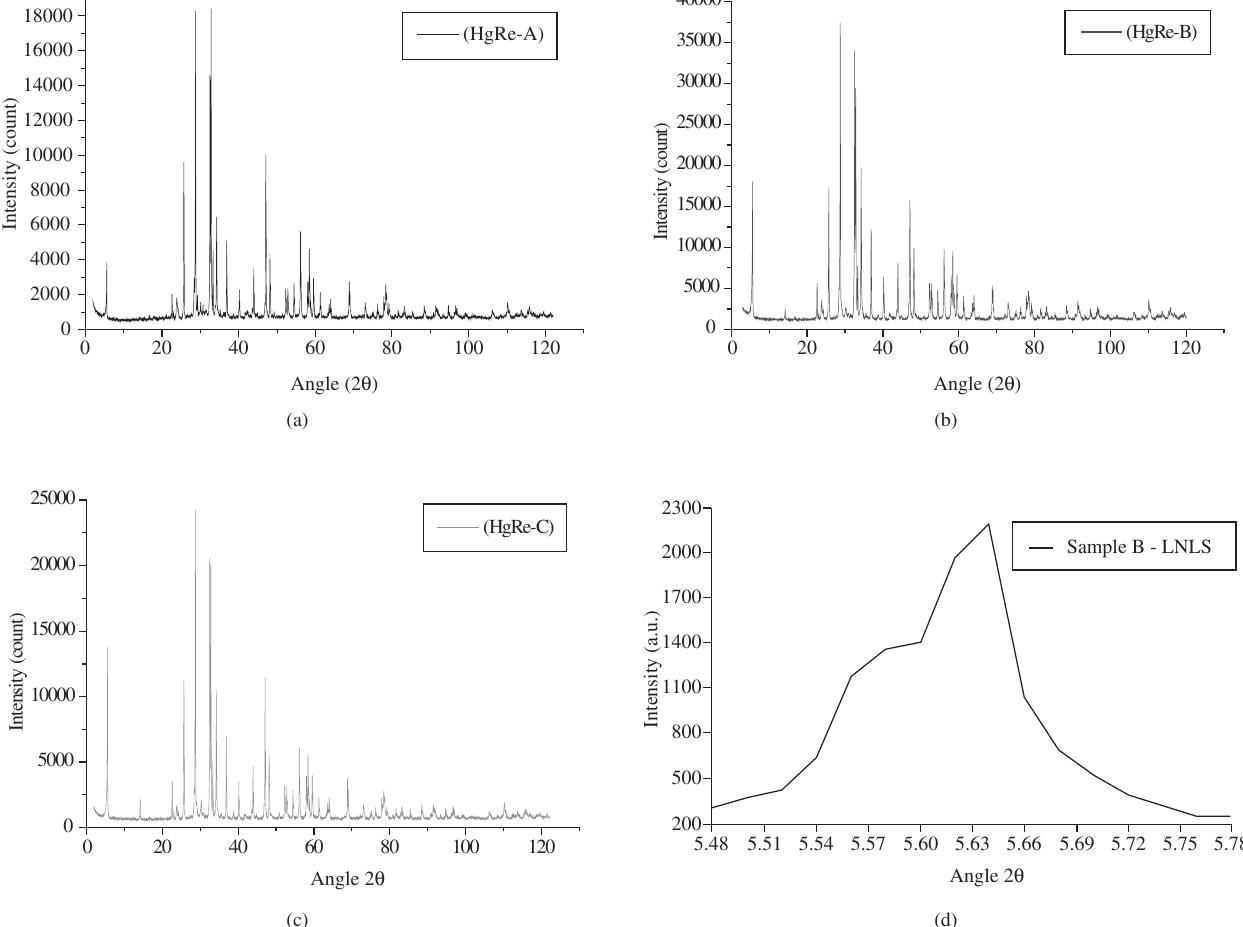
Figure 2. XRD for the samples a) A, b) B and c) C with Cu